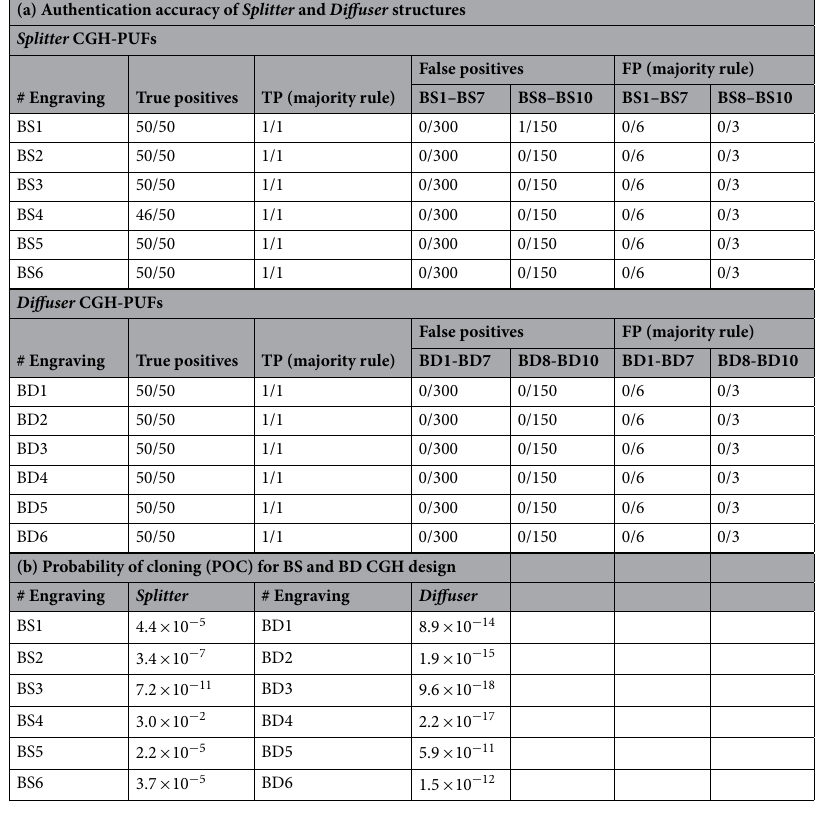
Table 1. Results: authentication accuracy and probability of